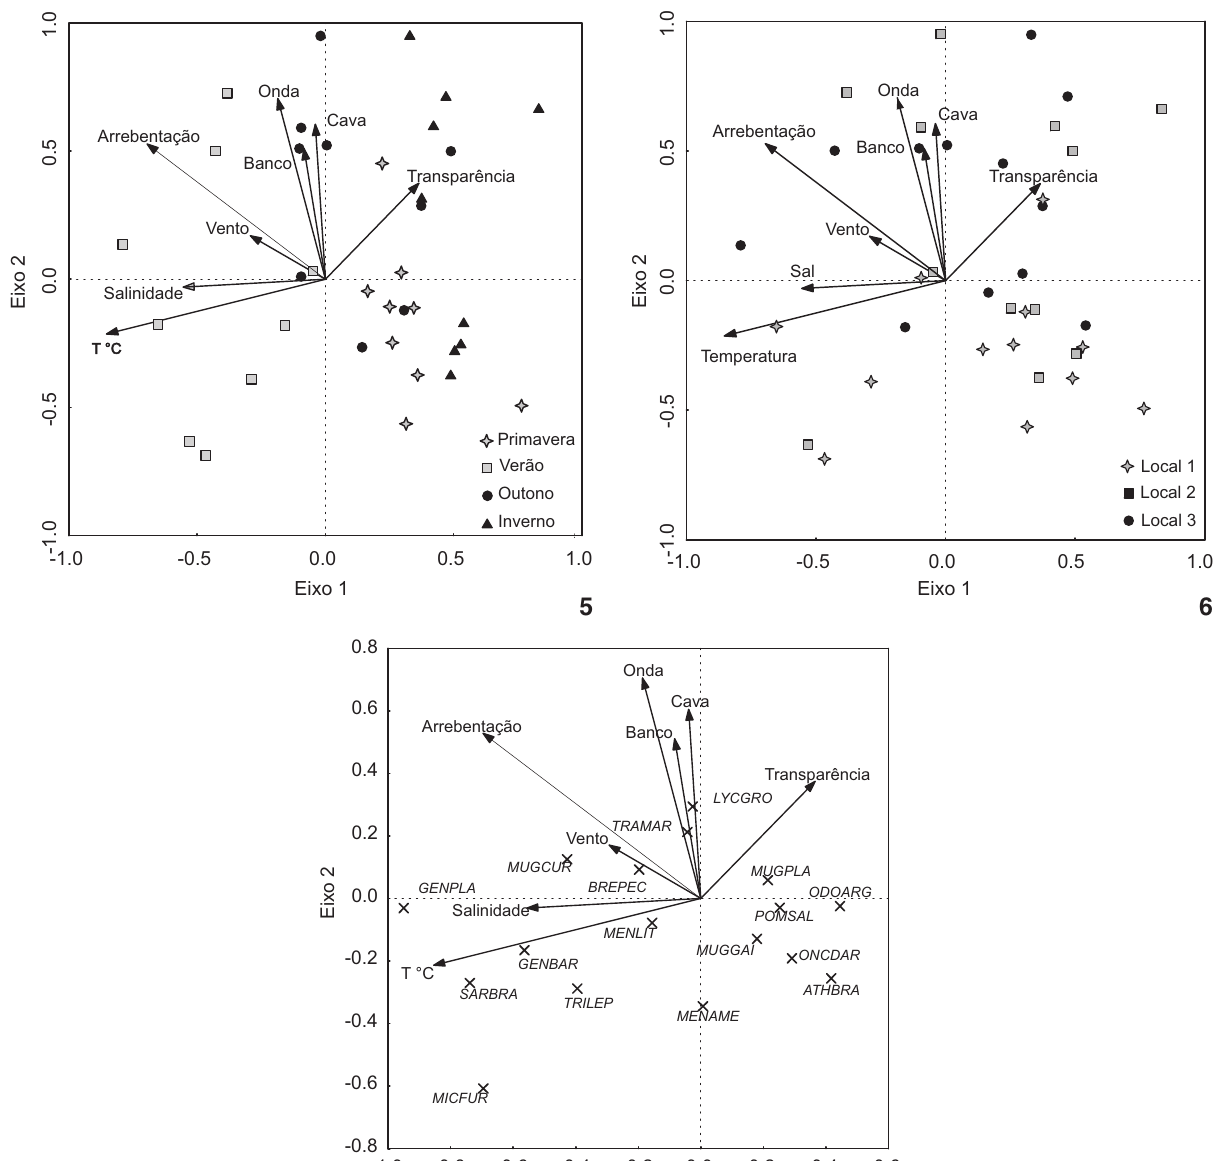
Figuras 5-7. Análise de Correlação Canônica (CCA) relacionando a abundância e composição de espécies com as variáveis ambientais: (5) representação sazonal das amostras (6) amostras espaciais,e (7) valores médios de abundância para cada espécies (ver código das espécies na tabela I). A variabilidade dos pontos (espécies, estações do ano e amostras espaciais) é explicada pelas variáveis ambientais que estão representadas pelos